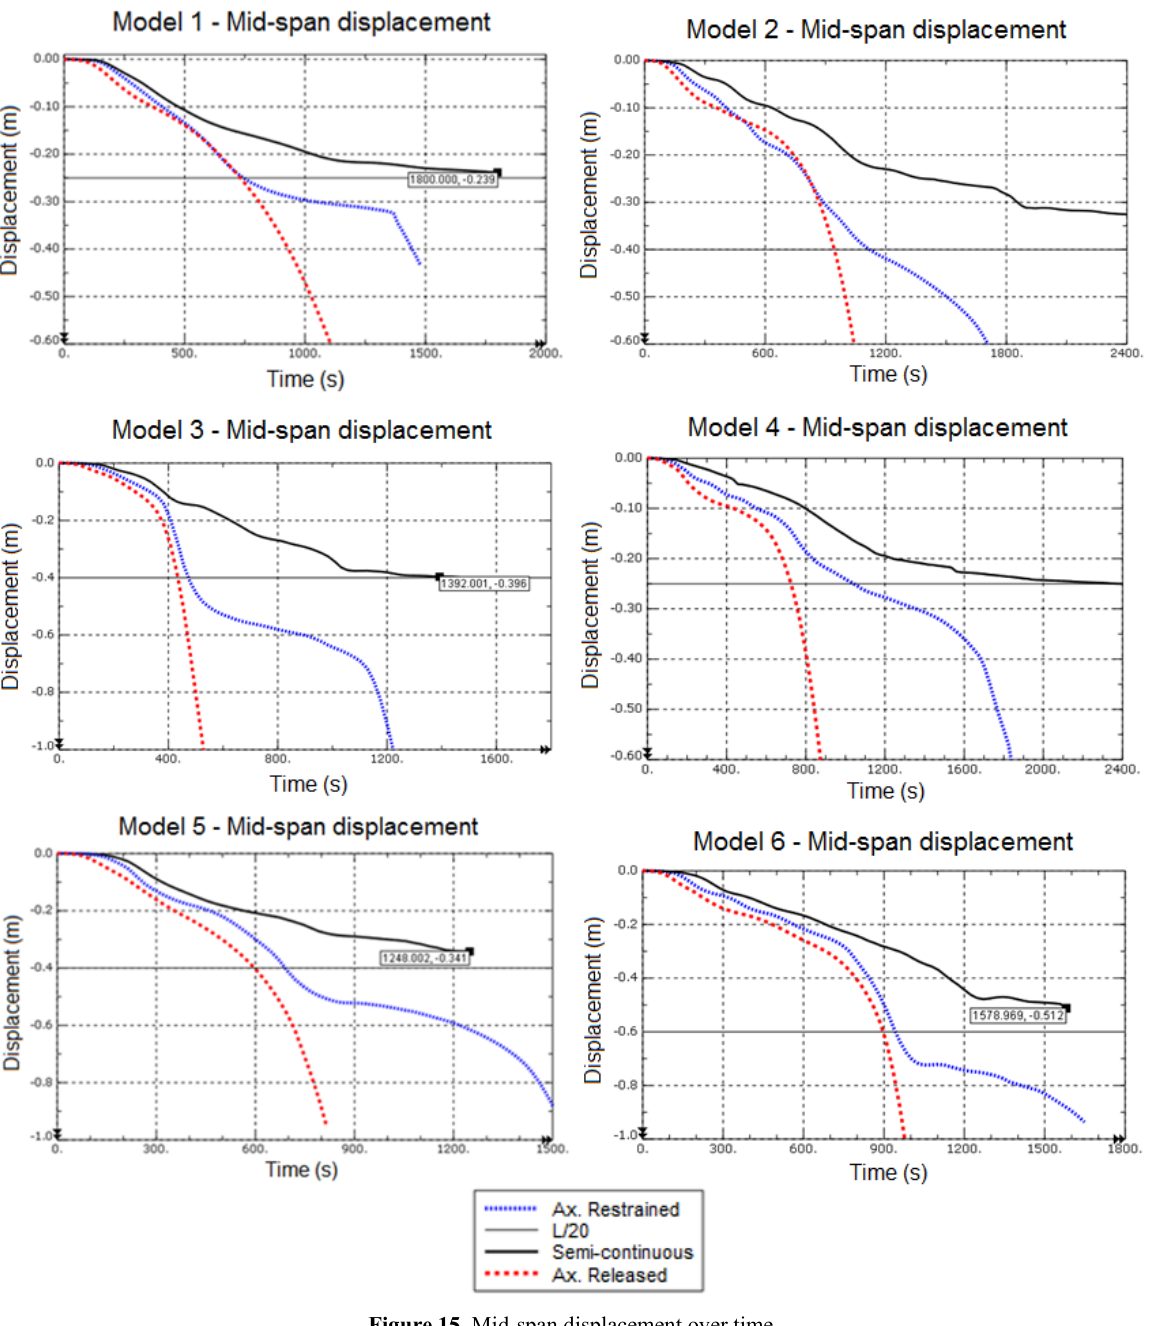
Figure 15. Mid-span displacement over